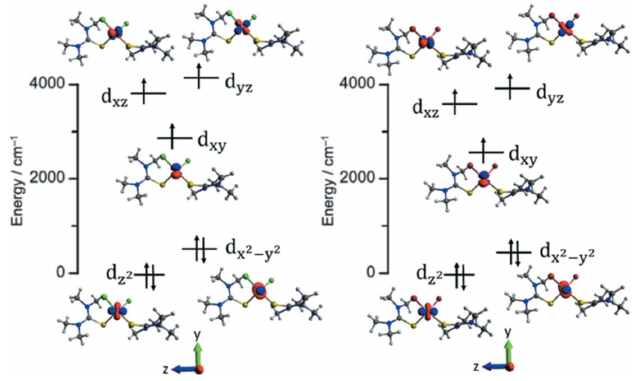
Figure 3 AILFT orbital energy diagrams for 1 (left) and 2 (right), The main d - orbital components and the corresponding isosurface plots are also